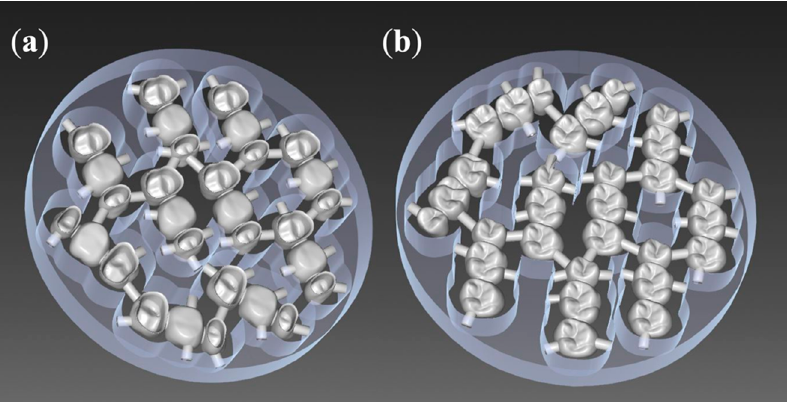
Figure 2. Ten fixed dental prostheses (FDPs) nested into one olymethylmethacrylate(PMMA) blank (inCoris, Dentsply Sirona): ( a ) bottom view, ( b ) top view.